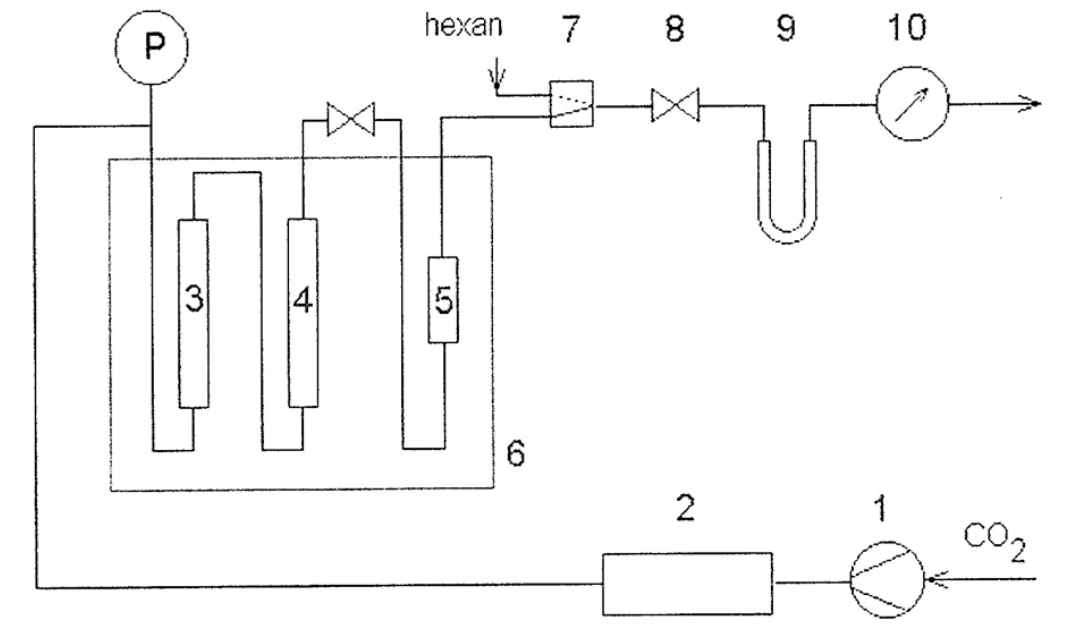
Figure 2. System for performing enzyme-catalyzed reactions in supercritical carbon dioxide: (1) compressor, (2) pressure control unit, (3) and (4) optional mixing or saturation units, (5) reactor, (6) oven, (7) rinsing valve, (8) micrometer valve, (9) trap, (10) gas